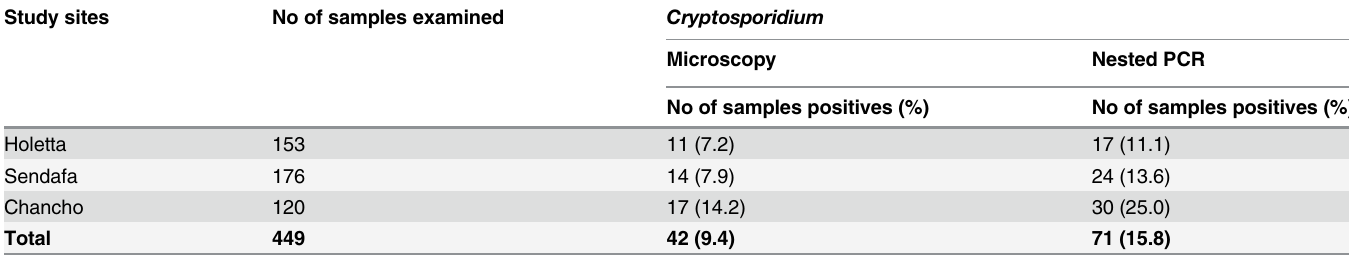
Table 1. Prevalence of Cryptosporidium in dairy calves as detected by microscopy and PCR in central Ethiopia (January — June, 2014).